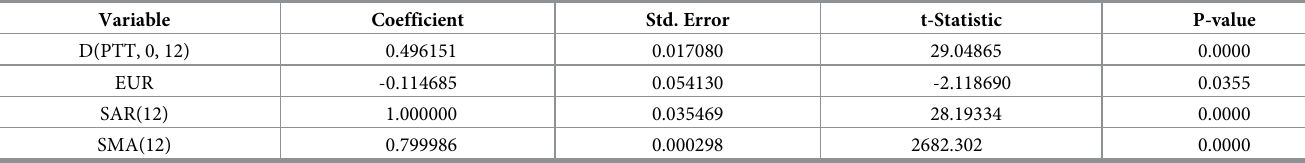
Table 6. The SARFIMAX( P , D , Q , r ) 12 coefficients for the PTT stock price dataset from January 2003 to August